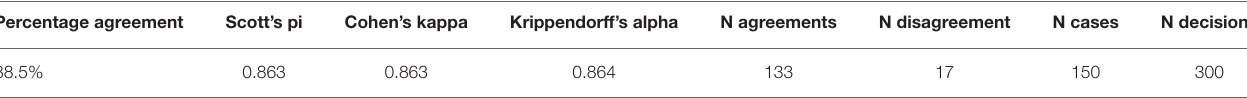
TABLE 4 | Intercoder agreement scores for a randomly selected sample of posts coded by a human coder and the topic model. Percentage agreement Scott’s pi Cohen’s kappa Krippendorff’s alpha N agreements N disagreement N cases N decisions